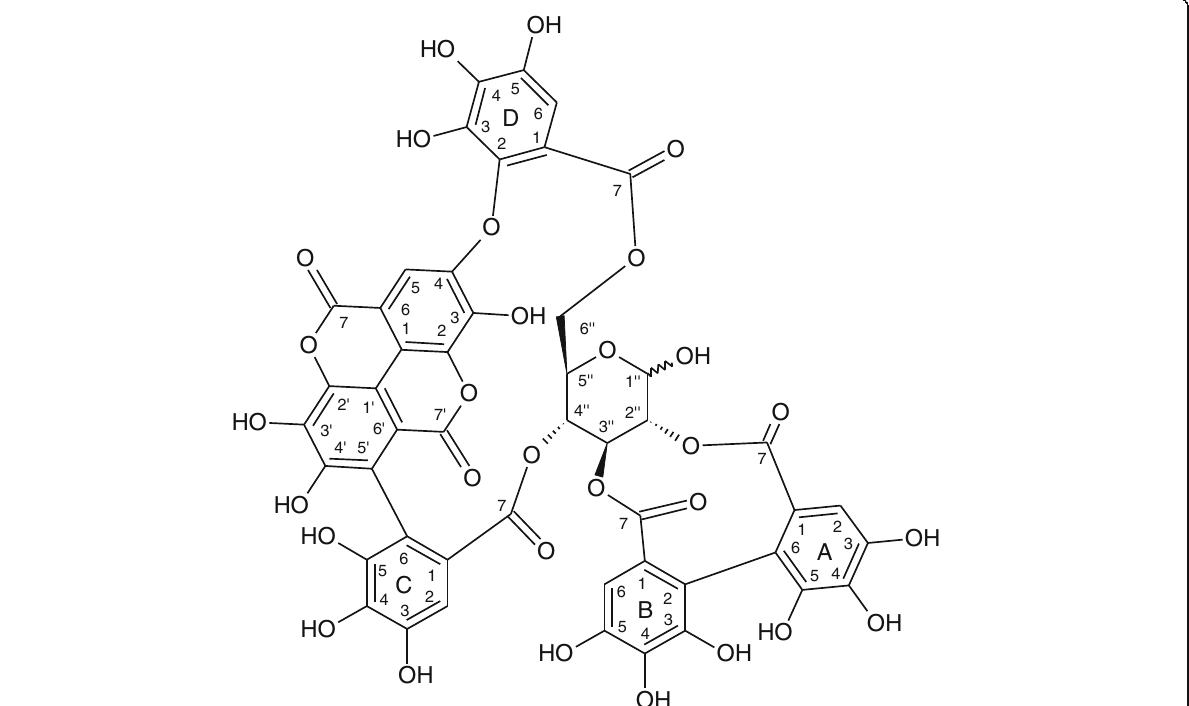
Fig. 3 Terchebulin. Tan powder. LC-MS (negative ion mode) m/z : 1083 (M-H); 1 H – NMR (in CD 3 OD): δ (ppm) 3.04 (t, J = 11.6 Hz, one of the H-6 ″